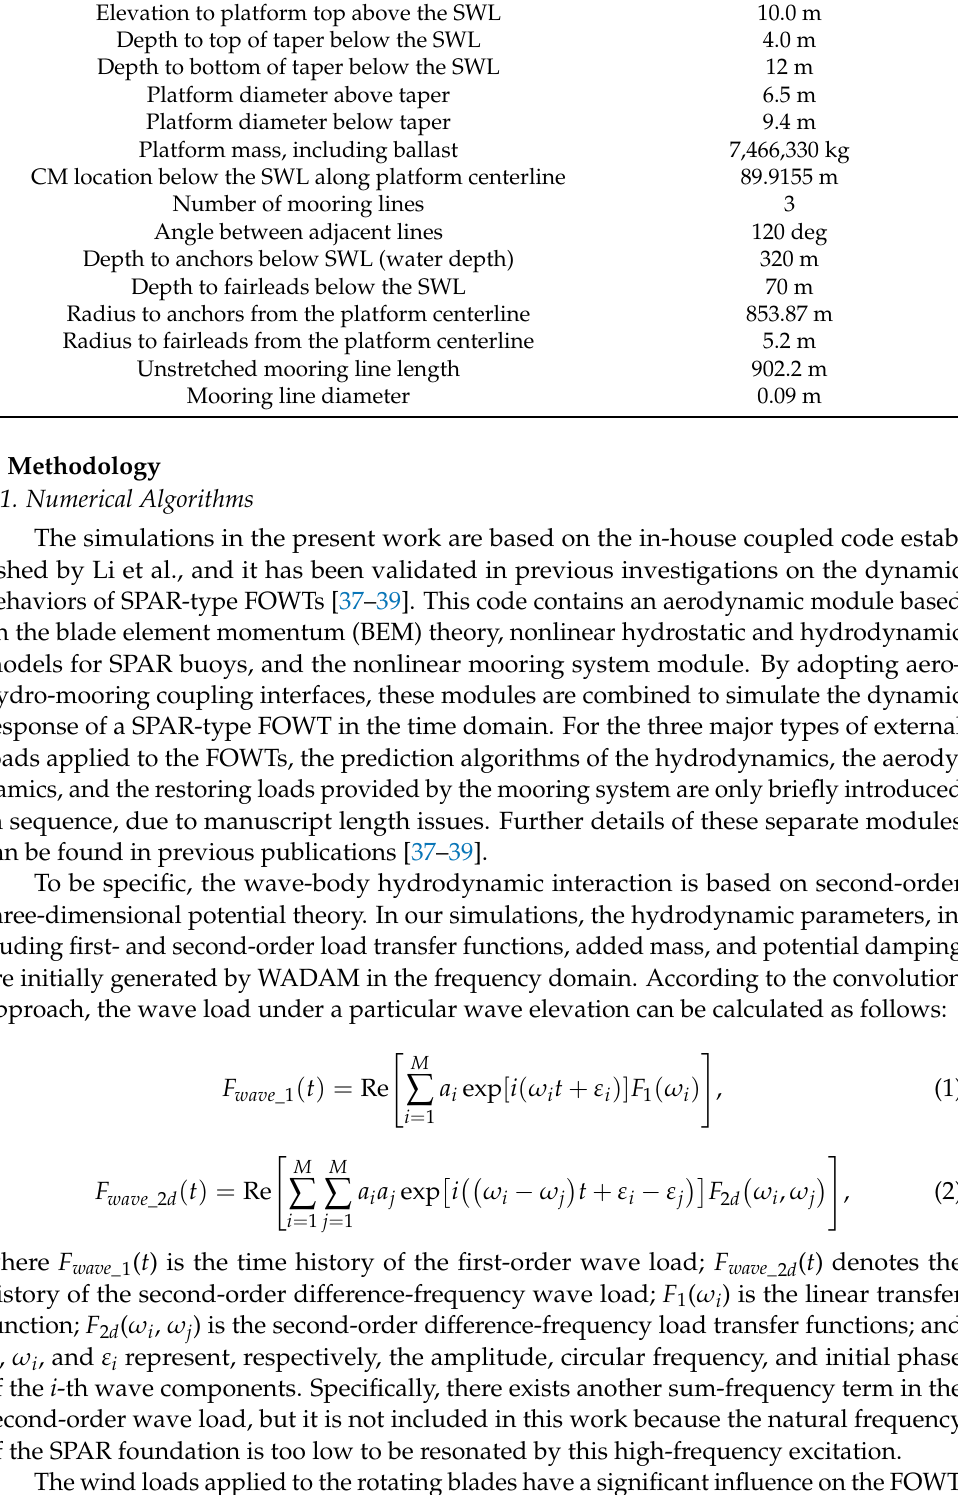
Table 2. Parameters of the SPAR-type floating foundation and the mooring system. Parameter Value Depth to platform base below the